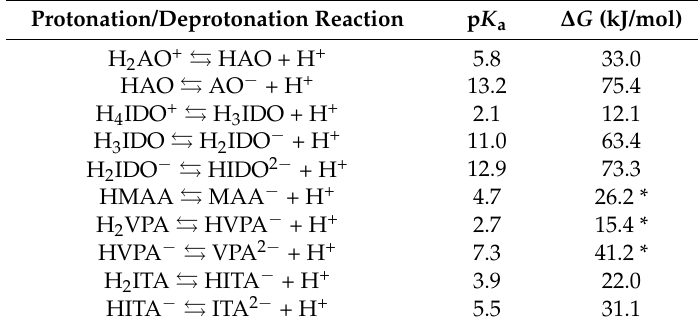
Table 4. Summary of p K a s and free energies of reaction for the active surface ligands and comonomers [52,53,63,64,68–71]. All values are reported at 25 ◦ C unless otherwise